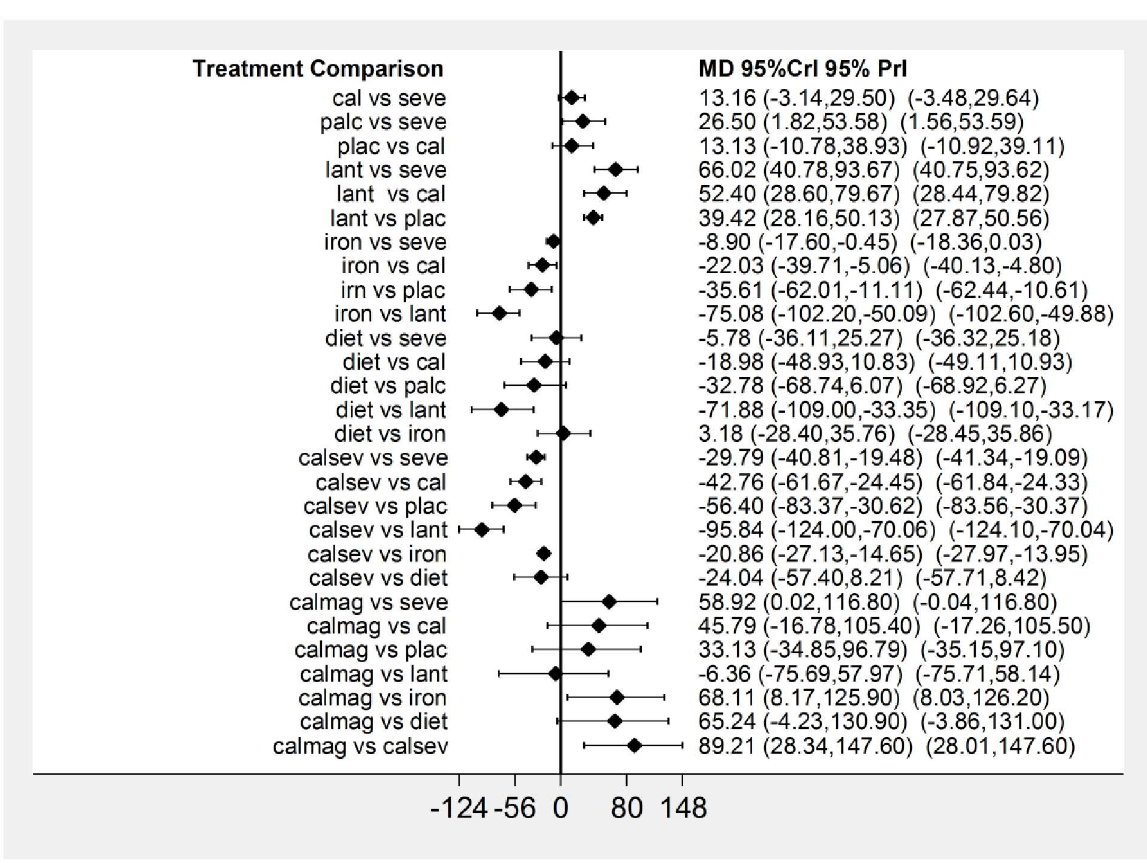
Fig 9. Network meta-analysis results for serum parathyroid hormone. Forest plot of effectiveness outcome for mean parathyroid hormone reductionat the end of the study period; MD: Mean difference;Crl: Credibleinterval; PrI: predictiveinterval.